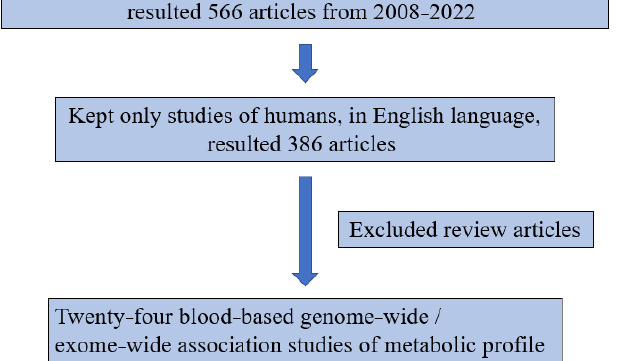
Figure 2. Diagram of literature review.